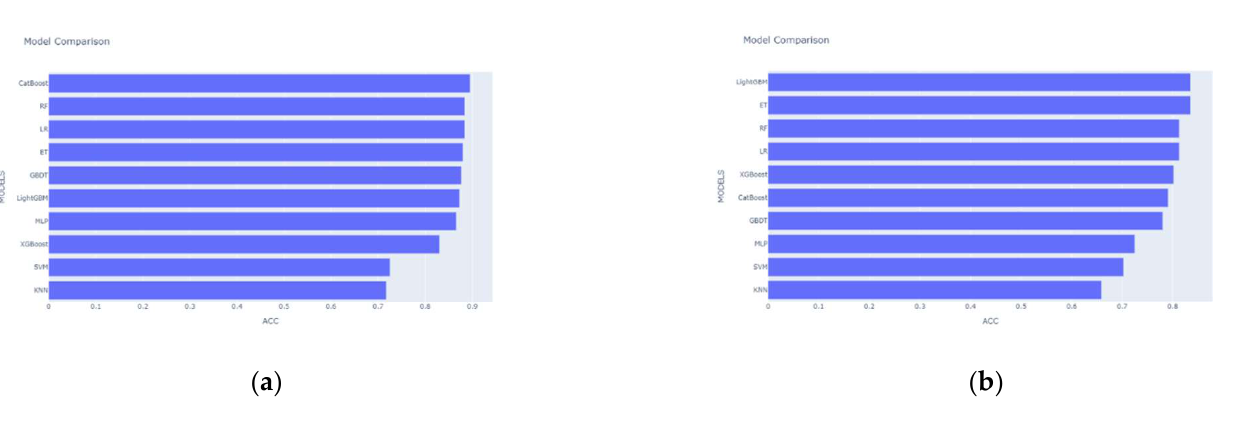
Table 3. Classification results of eleven classifiers.